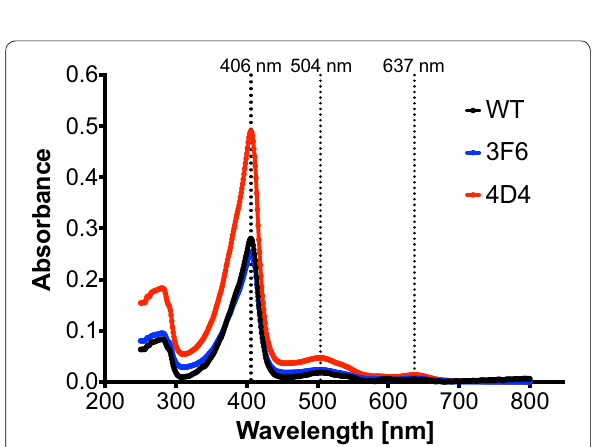
Fig. 4 UV‑vis spectra of purified WT (black), 3F6 (blue) and 4D4 (red), indicating the presence of a Soret band at 406 nm with a slight shoulder at ~ 385 nm, Q band at 504 nm and a charge‑transfer